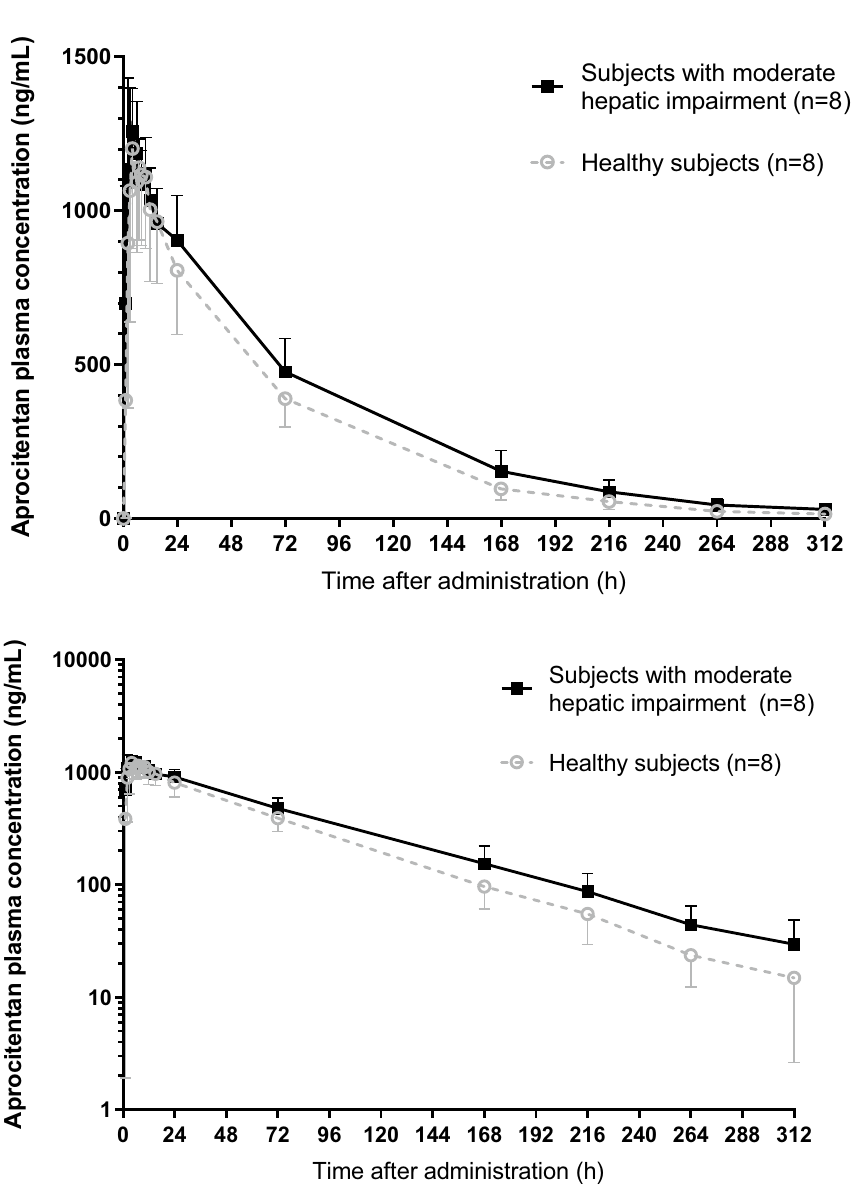
Figure 1. Arithmetic mean (± SD) plasma concentration–time profiles of a single oral dose of 25 mg aprocitentan on a linear (upper) and semilogarithmic scale (lower) in subjects with moderate hepatic impairment and matched healthy